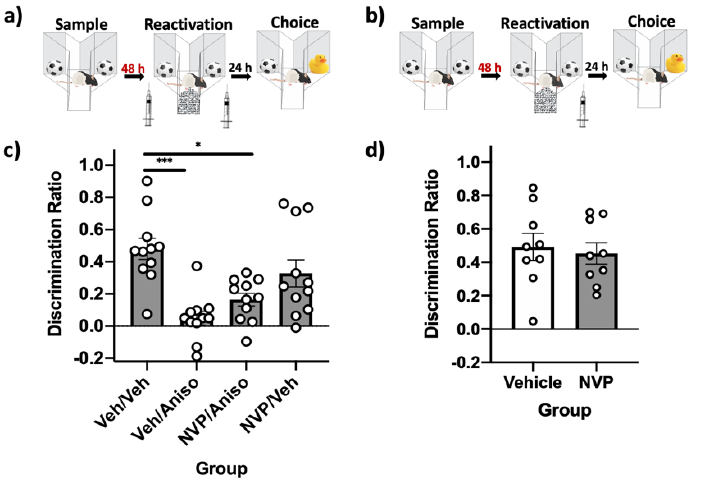
Figure 5. GluN2A-containing NMDARs in PRh are not required for destabilizing or reconsolidating remote object memories. ( a ) Remote SOR parameters, where a floor insert is required at the time of reactivation to destabilize remote object memories. PRh infusions were performed immediately prior to reactivation to target destabilization and prevent the impairing effects of post-reactivation infusion of anisomycin. ( b ) Remote SOR parameters, where only post-reactivation PRh infusions were performed to target reconsolidation. ( c ) Choice-phase DRs demonstrating that both groups receiving post-reactivation anisomycin were significantly impaired compared to the veh–veh condition. The veh–veh and NVP–veh groups had choice DRs that differed from their respective sample DRs, suggesting that only these groups had intact memory. ( d ) Choice-phase DRs demonstrating memory did not differ between groups. Both groups’ choice DRs differed significantly from their respective sample DRs, suggesting memory was intact. Bars are mean DR ± SEM; * p < 0.05, *** p < 0.001.